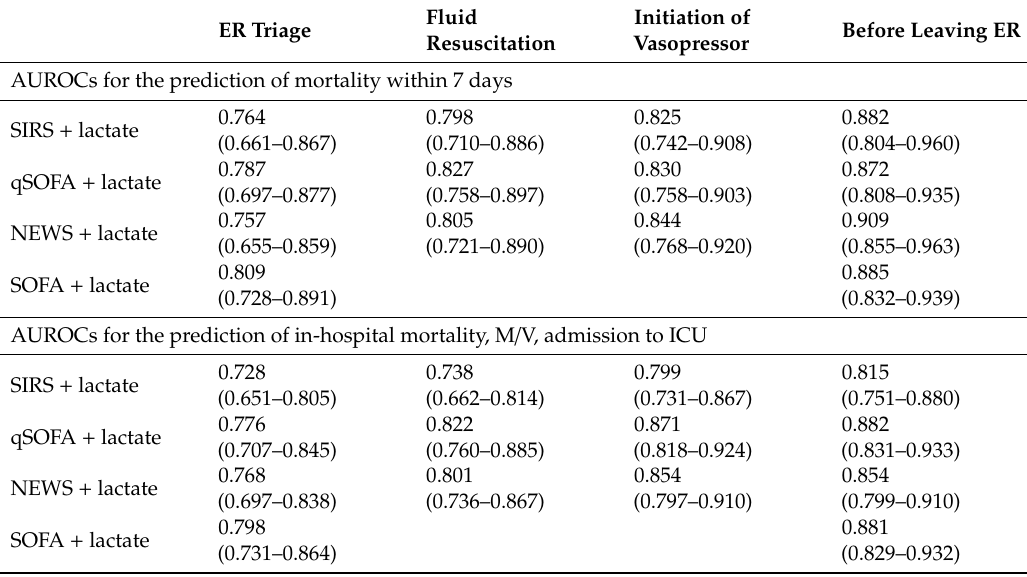
Table 4. Comparisons of areas under receiver operating characteristic curves with 95% confidence intervals for the prediction of mortality within seven days, in-hospital mortality, M / V, admission to ICU by combination of severity score and